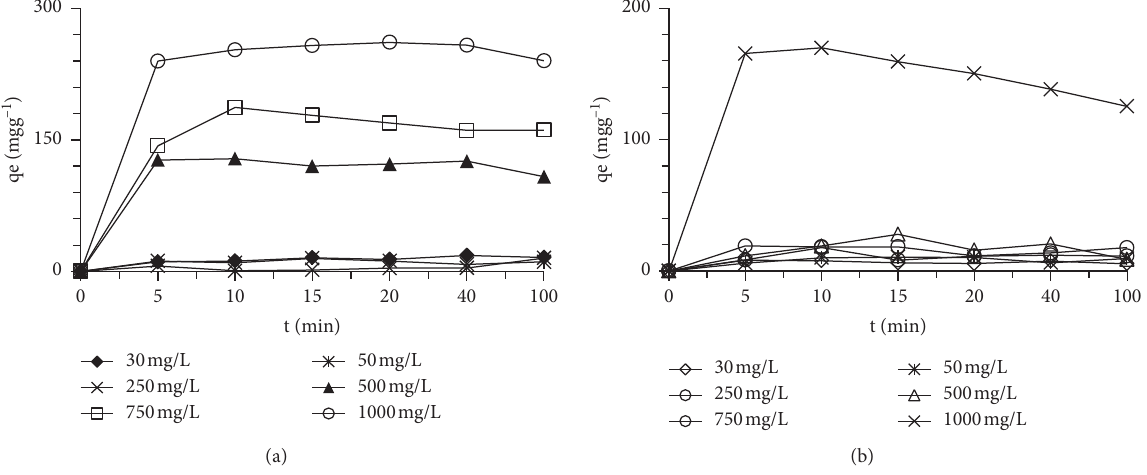
Figure 2: Effect of initial dye concentration on adsorbed quantities onto raw (a) and purified (b)